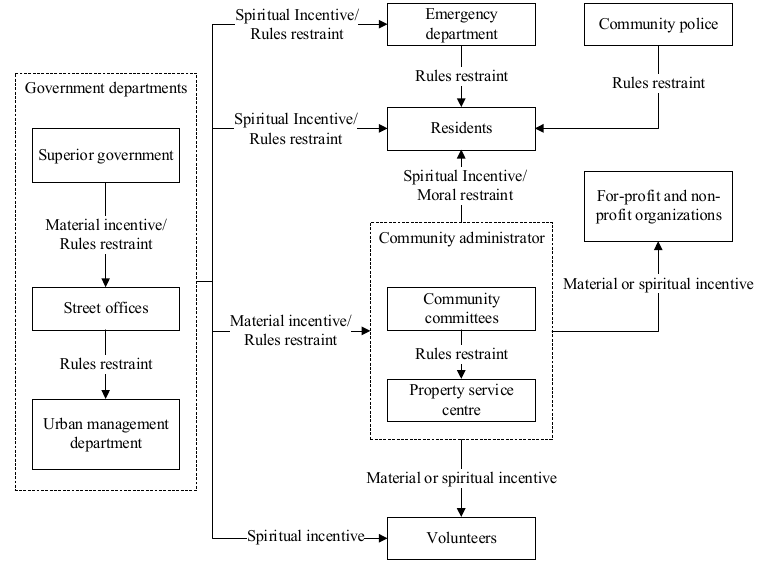
Figure 11. Division of incentive and restraint mechanisms for stakeholders in urban community DPM.